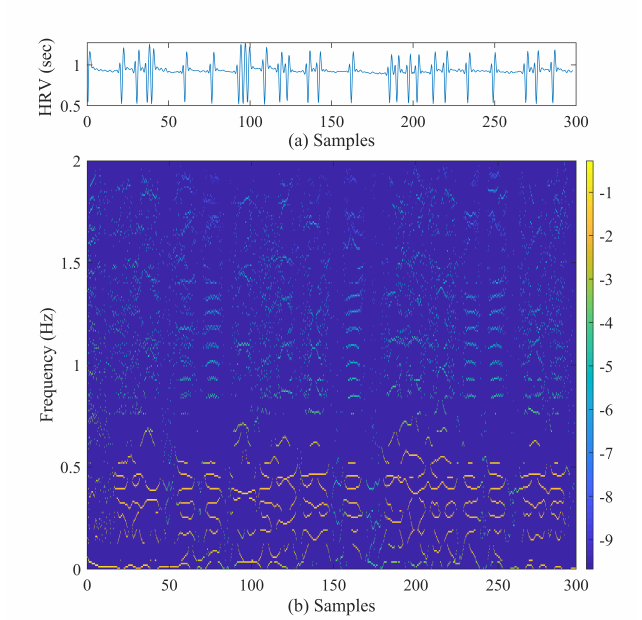
Figure 4. ( a ) Sample 5-min heart rate signal from a pre-AF ECG segment. ( b ) Time–frequency representation obtained using